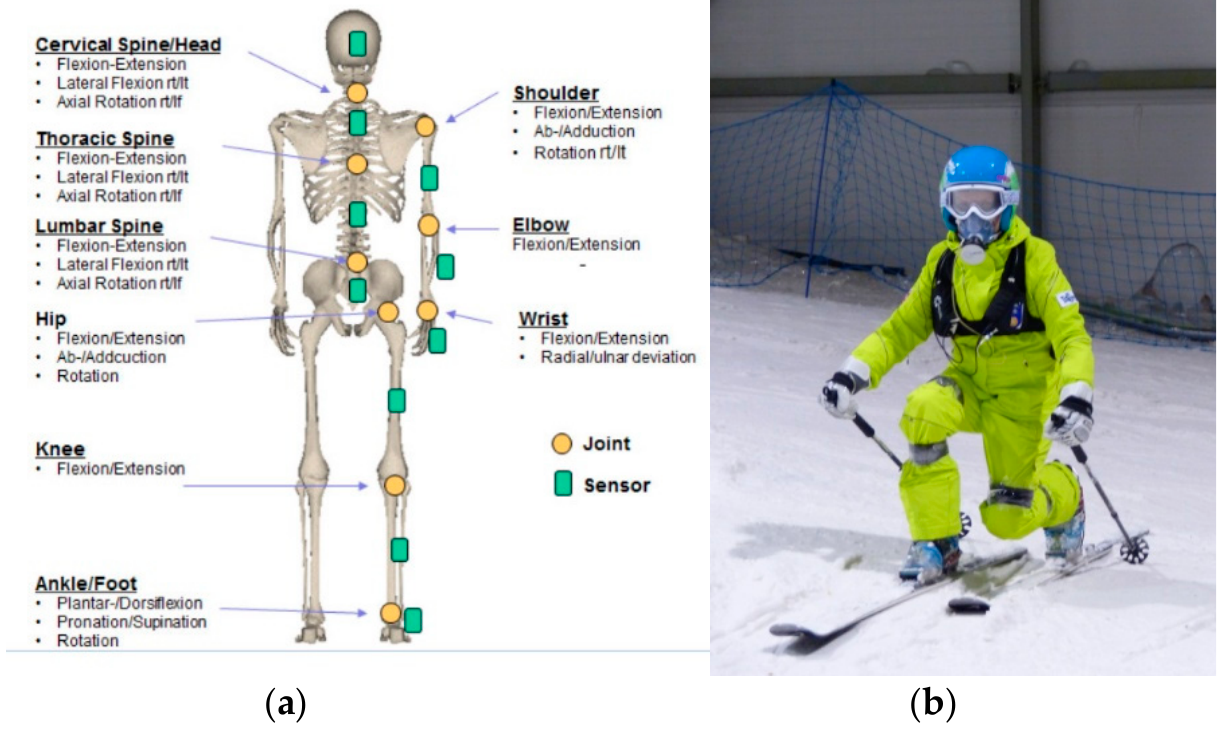
Figure 1. Inertial sensors: ( a ) placement on a skier (as per manufacturer’s instructions); ( b ) a skier with mounted sensors during the tests.